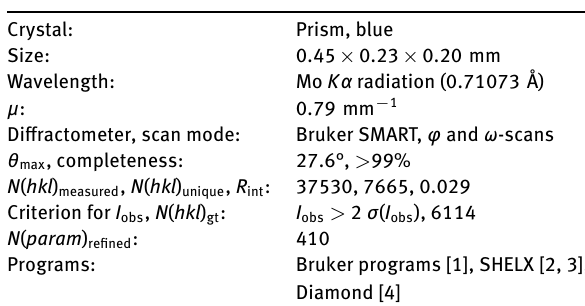
Table 1: Data collection and handling.